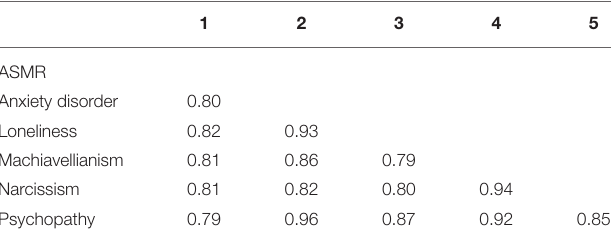
TABLE 3 | Hetero trait mono trait ratio (discriminant